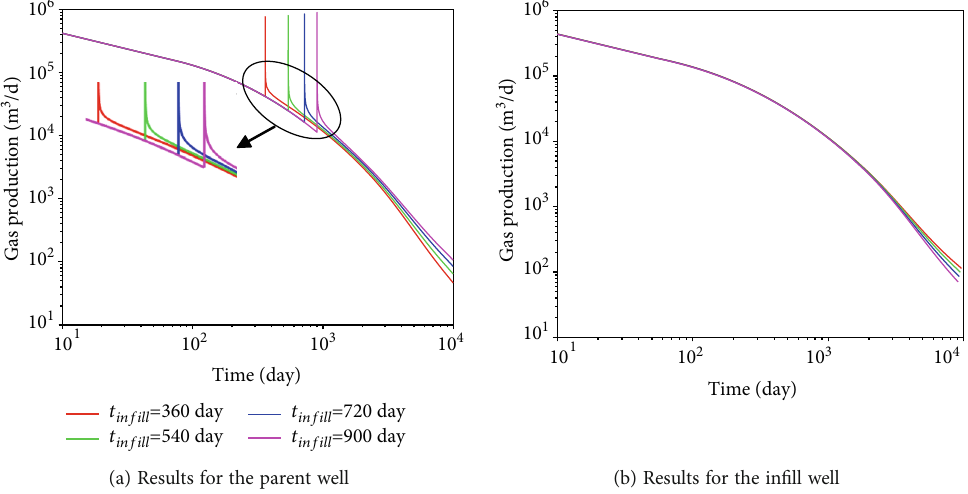
Figure 10: The e ff ects of the well in fi ll time on the gas production of both parent and in fi ll